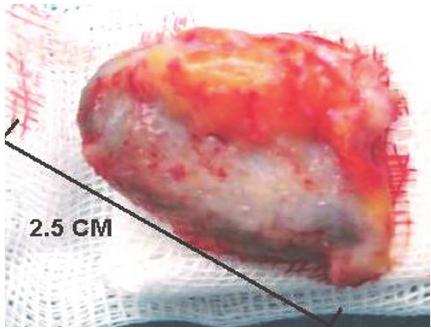
Figure 2: Postauricular pilonidal sinus